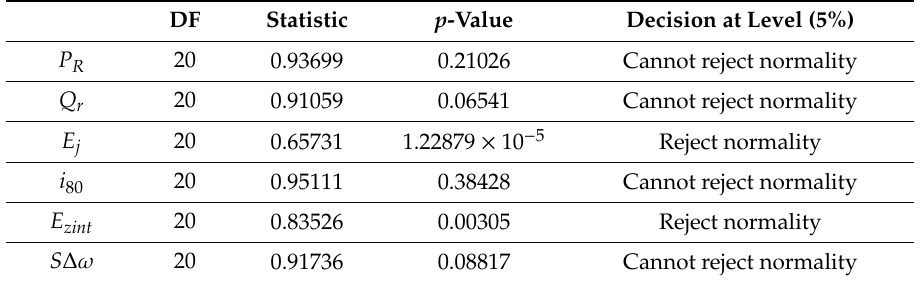
Table A2. Test results of the normality of the Shapiro-Wilk distribution of variables for the process of corn grinding.